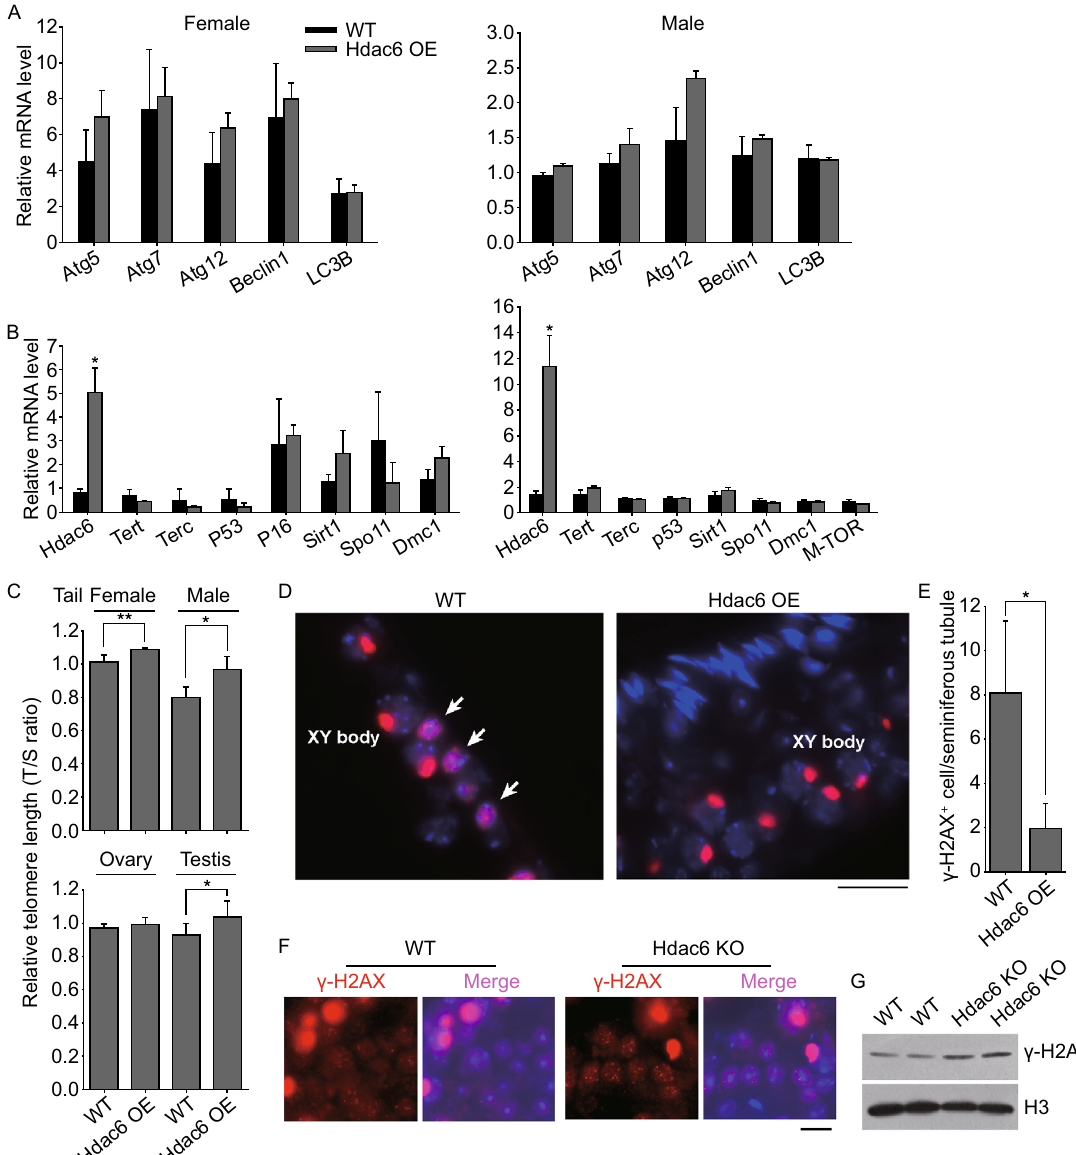
Figure 2. In fl uences of Hdac6 overexpression on telomere length maintenance and DNA damage response in vivo . (A) Relative mRNA levels by qPCR analysis of genes associated with autophagy of ovaries or testis of old WTand Hdac6 OE females and males in B6C3F1 hybrid background. (B) Relative mRNA levels of genes related to telomere, meiosis and aging in ovaries or testis of old mice. WT mice were 15 – 16 months old and Hdac6 OE mice 19 months old. (C) Relative telomere length shown as T/S ratio by qPCR analysis. For telomere analysis of tails, females were aged at 14 – 15 months, and males at 12 – 14 months ( n = 4). For telomere analysis of gonads, female mice were 17 – 18 months old, and WT males at 15 months old, and Hdac6 OE males at 19 months old. The data are expressed as mean ± SD ( n = 4). (D and E) DNA damage shown by γ H2AX foci is reduced in the seminiferous of Hdac6 OE testis than in WT mice (19 month old). (D) Immuno fl uorescence of γ H2AX indicated DNA damage with fragmented DNA (white arrows) and paired XY chromosomes at pachytene (indicated as XY body) in the seminiferous tubule. (E) Quanti fi cation of average number of γ H2AX positive cells with fragmented DNA per seminiferous tubule of WT and Hdac6 OE testis sections. (F and G) DNA damage is increased in Hdac6 knockout (KO) mice compared with WT mice. (F) Immuno fl uorescence of γ H2AX showing noticeable DNA damage foci in spermatocytes of Hdac 6 KO testis but fewer foci in WT mice. Large spots in red are XY bodies, shown as in (D). (G) Western blot analysis of γ H2AX protein levels. H3 served as a loading control. Scale bar = 20 μ m. * P < 0.05, ** P <